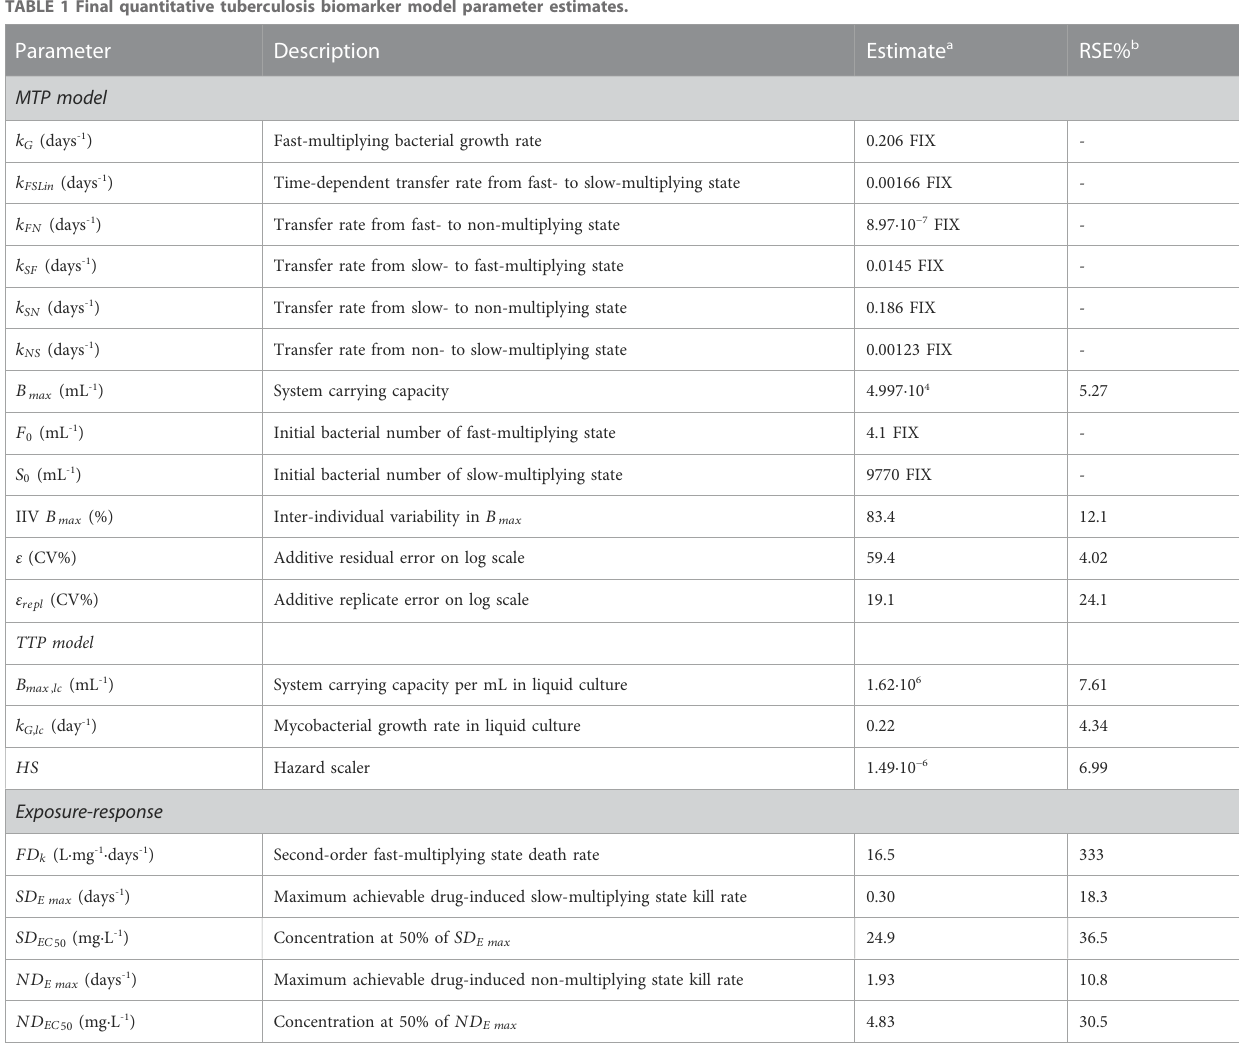
TABLE 1 Final quantitative tuberculosis biomarker model parameter